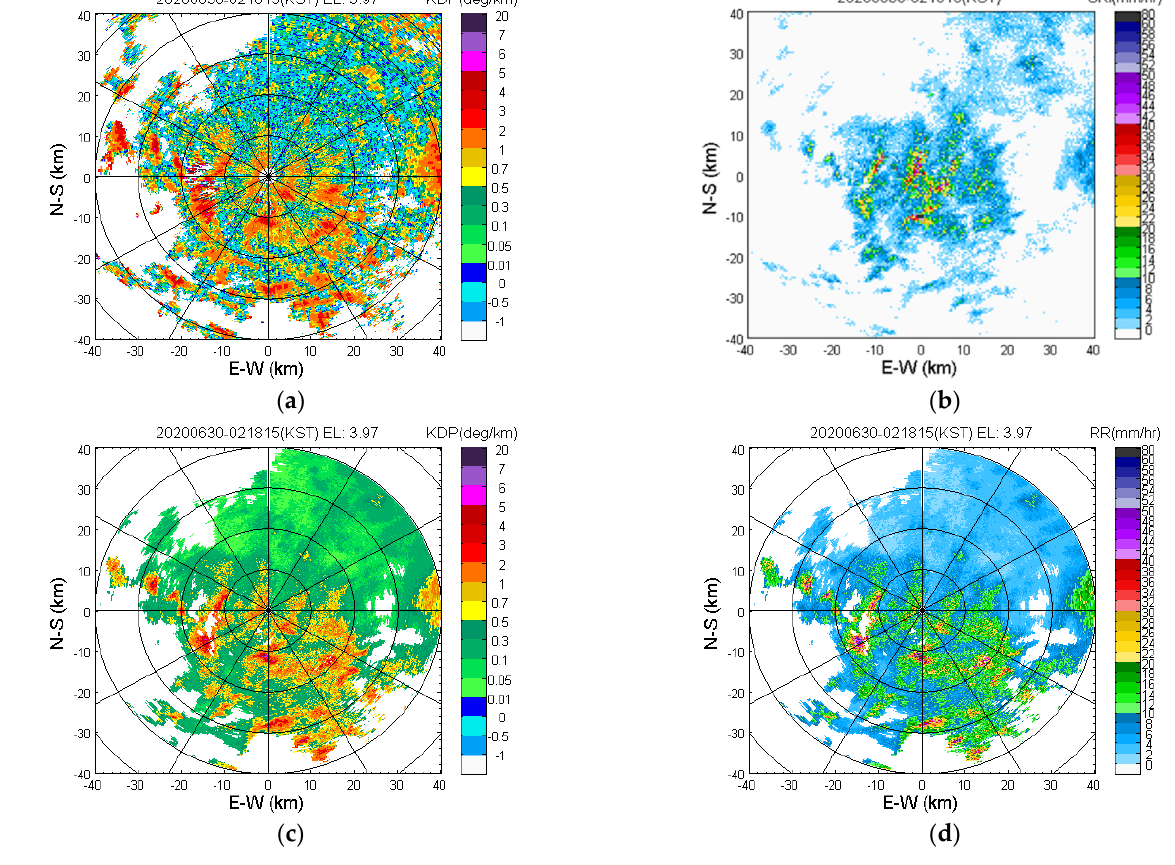
Figure 3. Prior and post application of the distributed specific differential phase estimation method, and the rainfall estimation results (30 June 2020, at 2:18): ( a ) K DP (JRC); ( b ) Surface Rainfall (SAM_SRI); ( c ) K DP (new); ( d ) Rainfall (SAM_RR). Table 1. The properties of rain gauge and various radar data for accuracy evaluation.